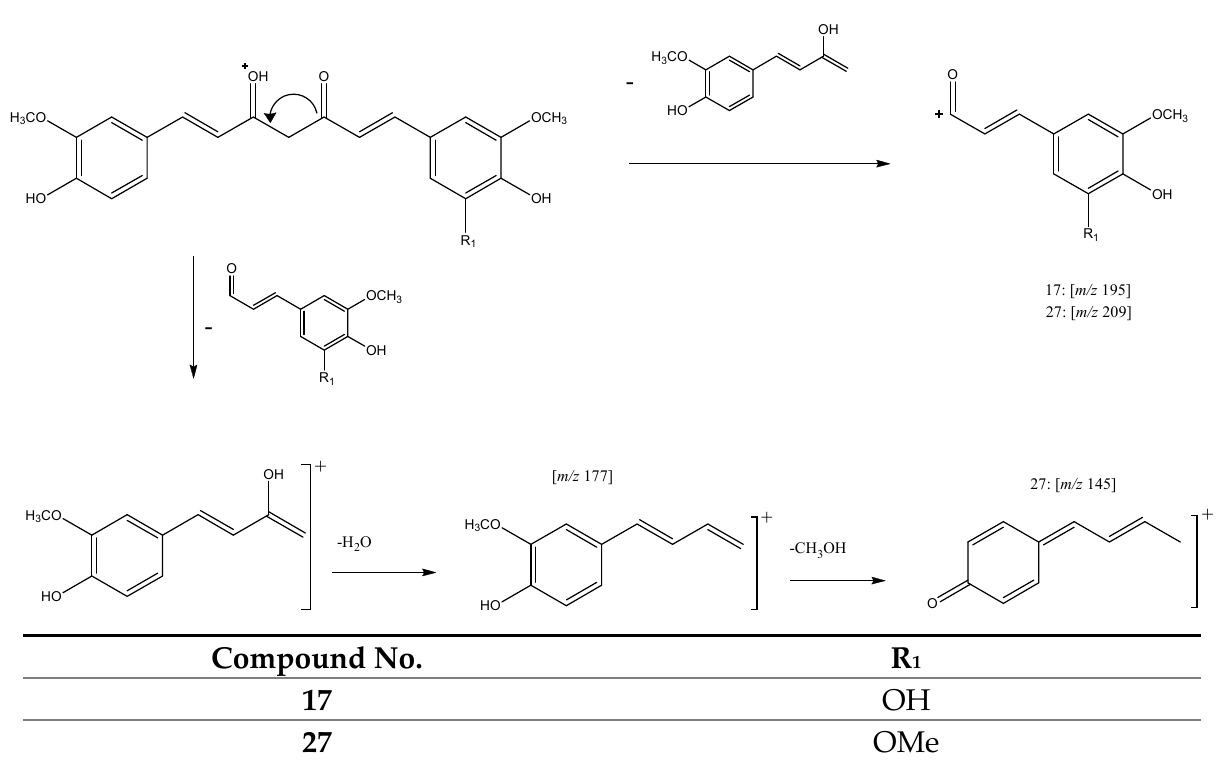
OH Figure 4. Fragmentation pathway of compounds 14 , 18 and 24 . Finally, in this group of compounds, peaks 17 (Rt = 16.21 min) and 27 (Rt = 18.61 min) with [M + H] + at m/z 385.1276 (C 21 H 21 O 7 ) and m/z 399.1408 (C 22 H 23 O 7 ) were tentatively as- signed to curcumalongin C and 1-(4-hydroxy-3,5-dimethoxyphenyl)-7-(4-hydroxy-3- methoxyphenyl)-1,6-heptadiene-3,5-dione, respectively. Both peaks hold a positive